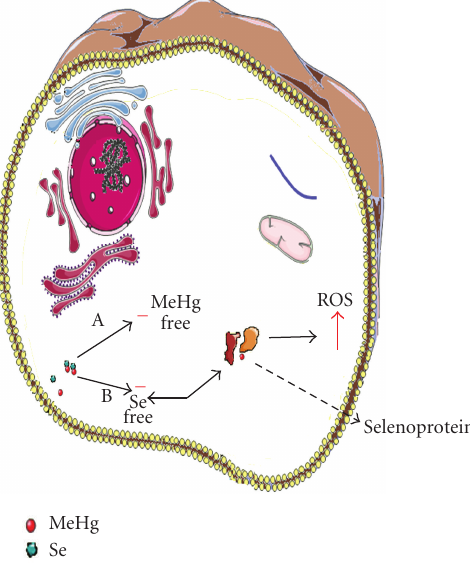
Figure 8: Possible role of Selenium (Se) on MeHg toxicity: (A) MeHg toxicity reduced by formation of complex MeHg-Se; (B) MeHg toxicity increased due Se depletion by formation of complex MeHg-Se: ↓ Selenoprotein activities and synthesis and ↑